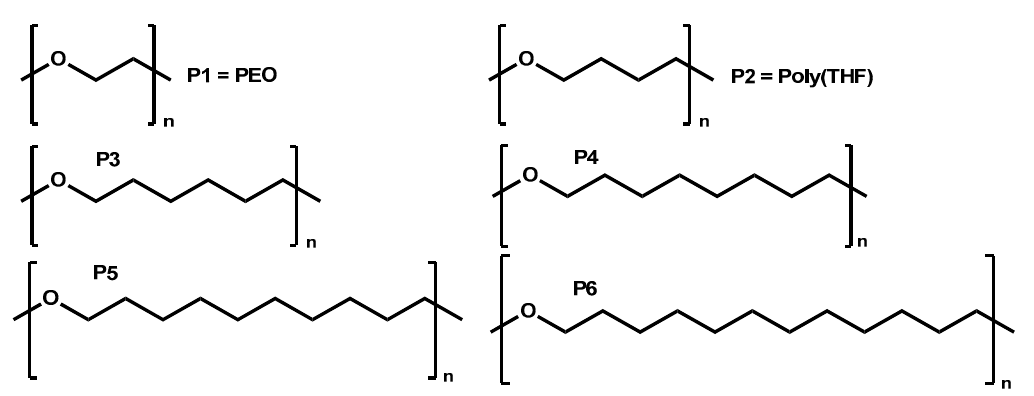
Figure 1. Chemical structure of the different polyethers employed in this work.